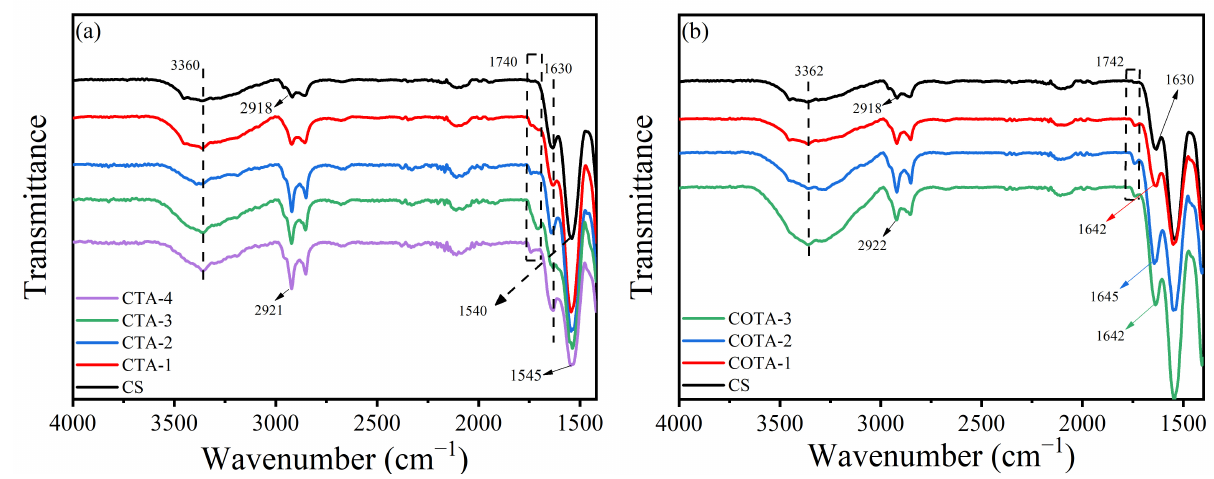
Figure 2. ( a ) FT ‐ IR spectra for CS and CTA films; ( b ) FT ‐ IR spectra for CS and COTA films.